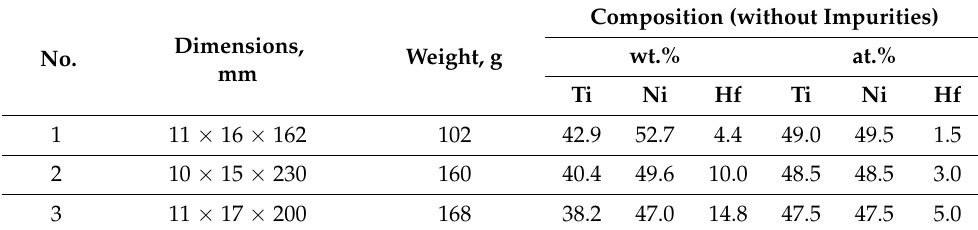
Table 3. Chemical composition of the melted TiNiHf